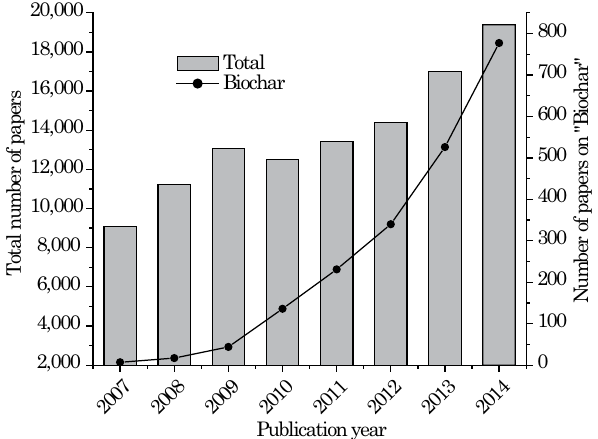
Figure 1. Number of scientific articles per year for the queries: “black carbon/black C or pyrogenic carbon/pyrogenic C or charcoal” = Total (columns and left axis) and for the query “biochar” (line and symbol, right axis). Search on April 10,